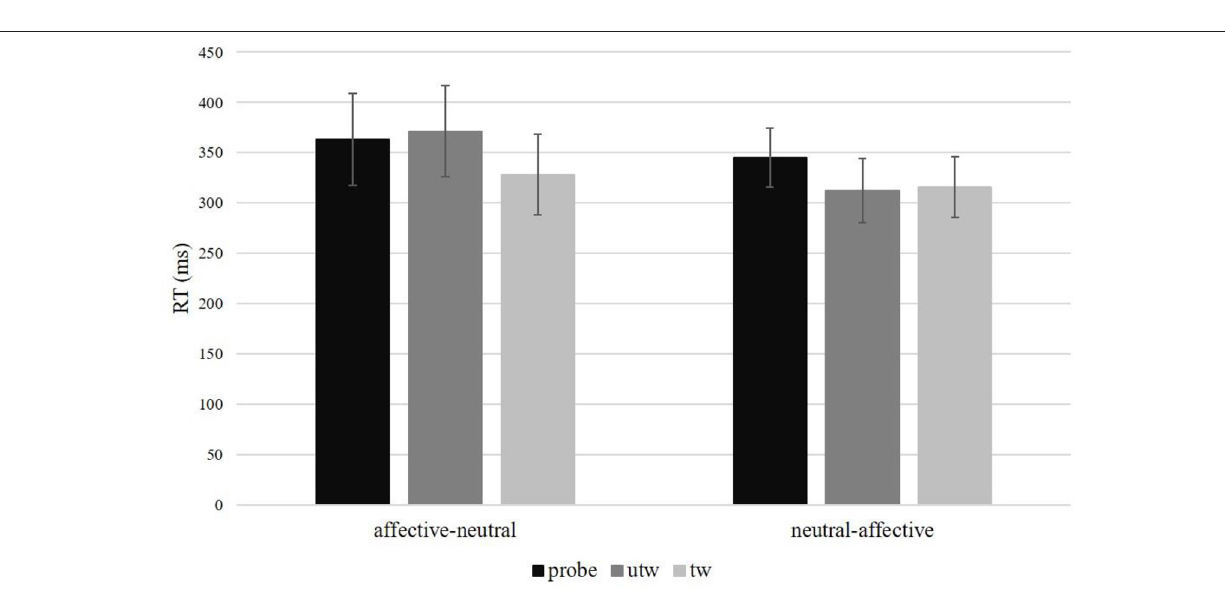
FIGURE 6 | Response times in milliseconds (ms) and standard errors per picture type and task sequence. probe, untrustworthy-probe; utw, truthful untrustworthy; tw, truthful